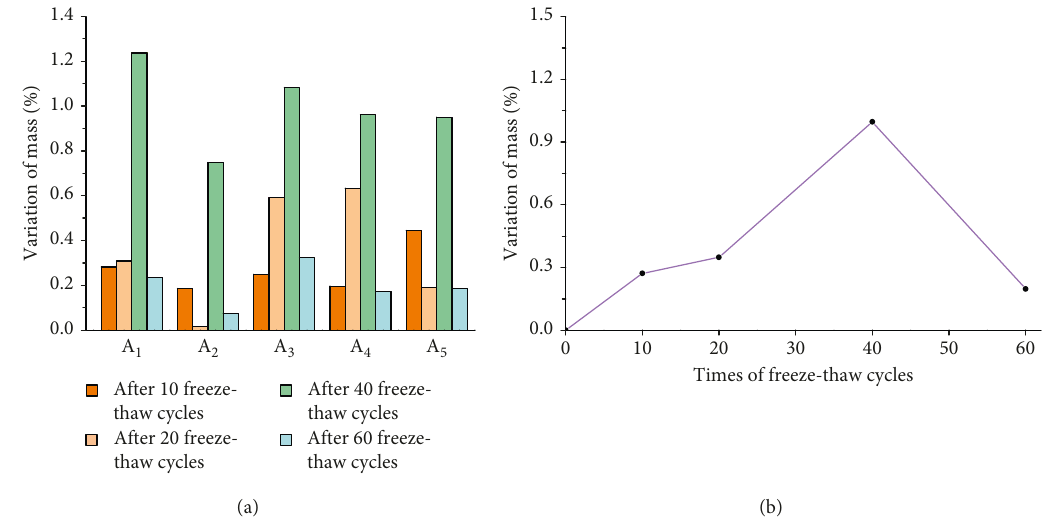
Figure 5: The variation of mass under different freeze-thaw cycles (0, 20, 40, and 60).